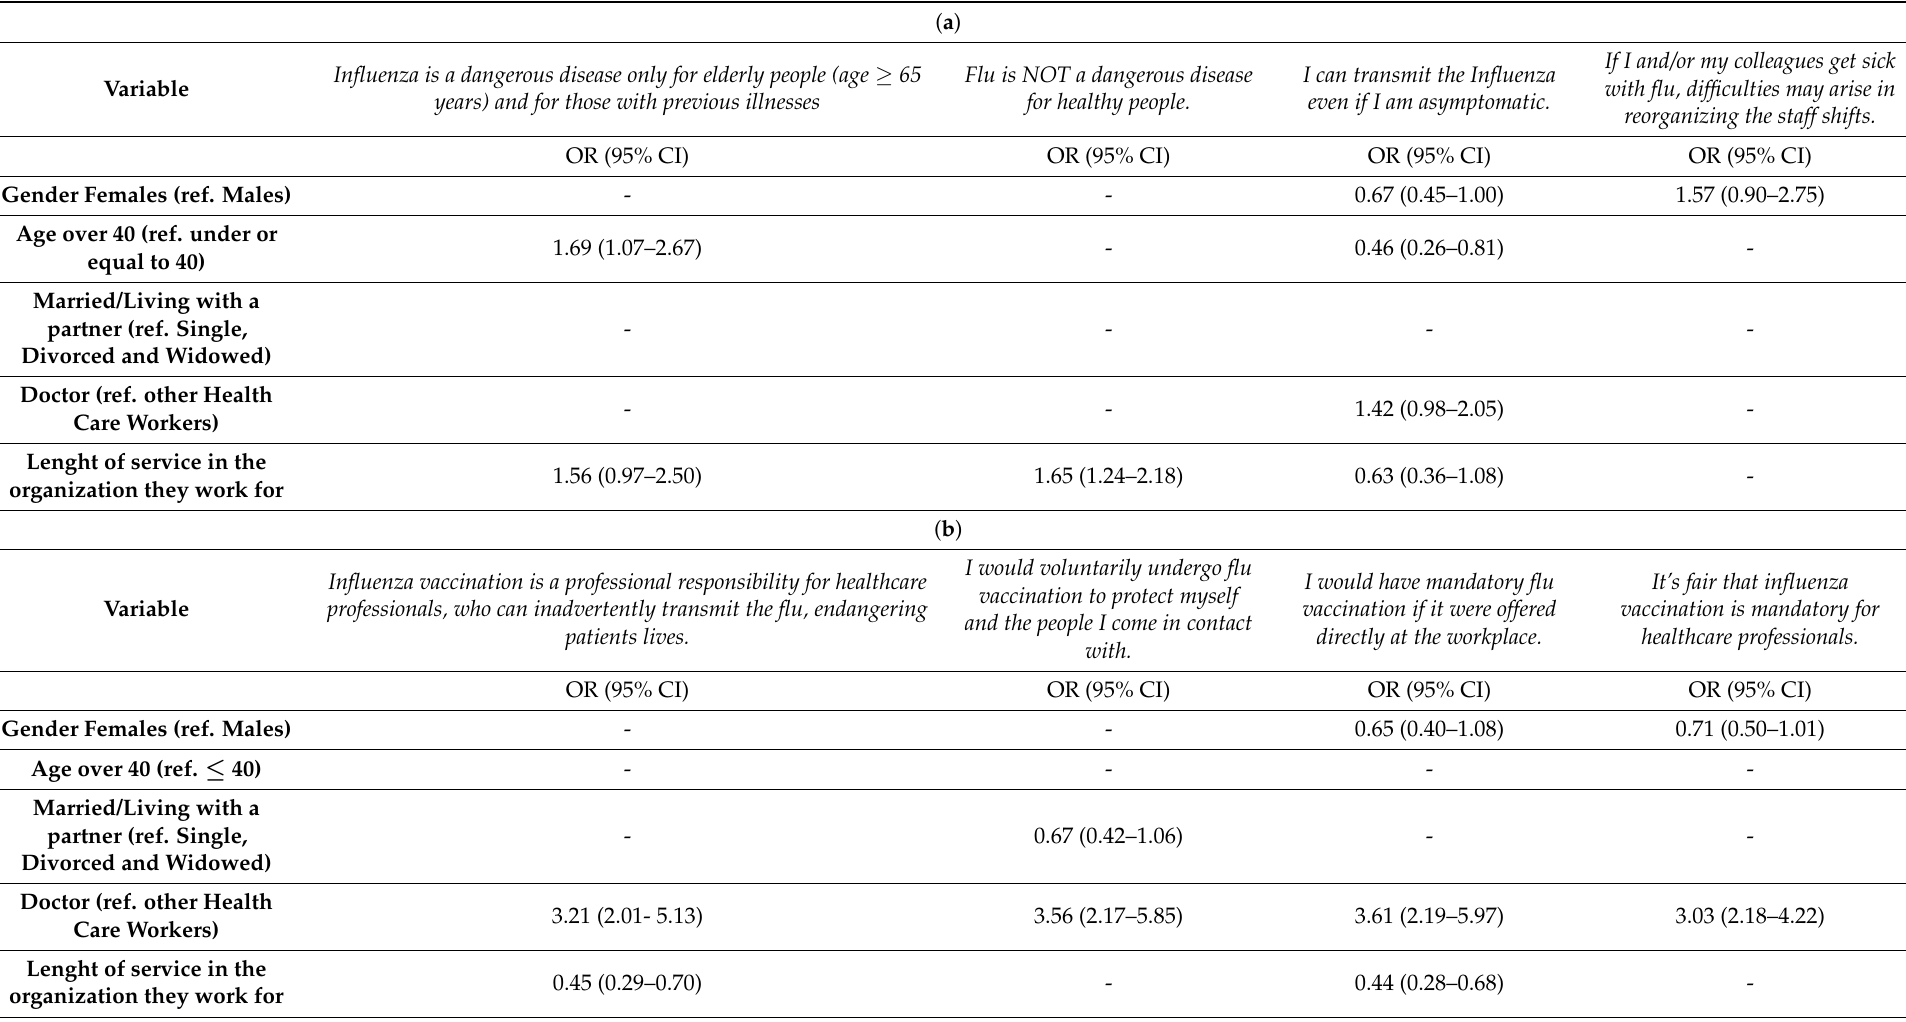
Table 3. ( a ) Multivariate analysis—what do HCWs think about influenza? ( b ) Multivariate analysis—vaccine obligation. ( c ) Multivariate analysis—promotion and vaccine